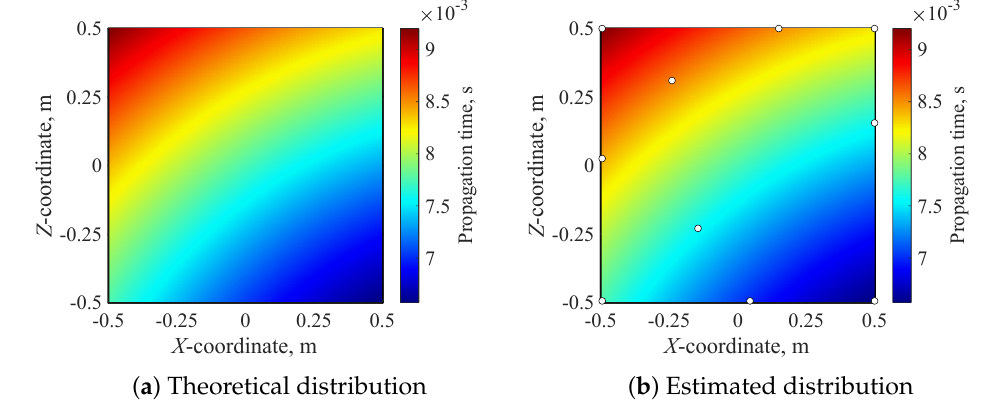
Figure 5. Distributions of propagation time in the sound source